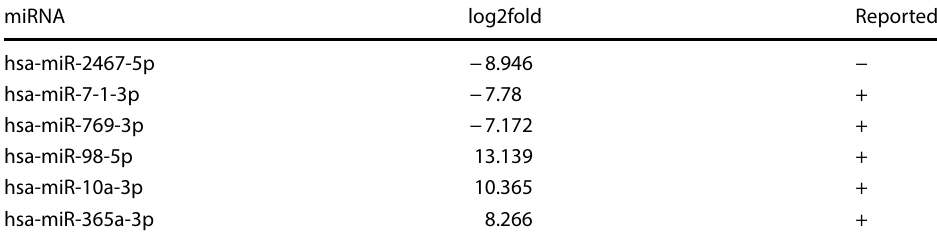
Table 8 Top three downregulated and upregulated miRNA transcripts in OS-EP compared to OS-P cells